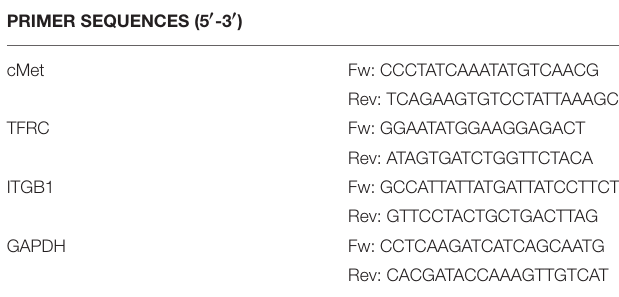
TABLE 3 | Sequences of primers used in this